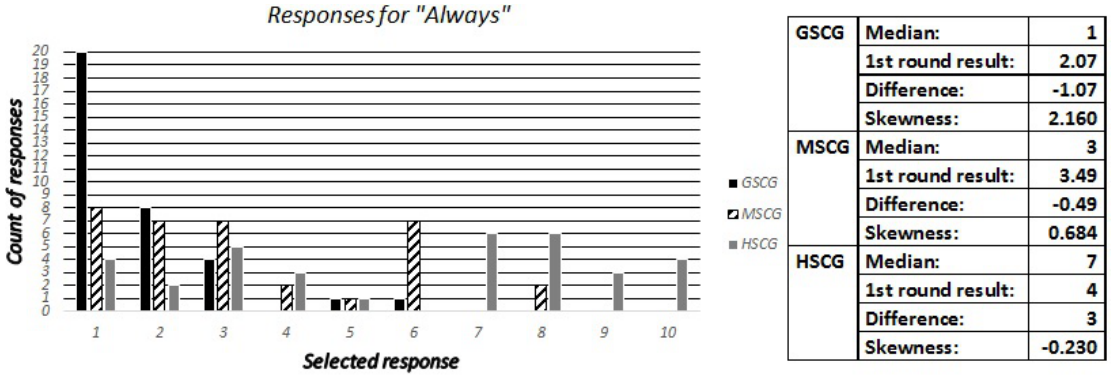
Figure 5. Expert predictions for question 4: Distribution of “Always”-response and comparison results.